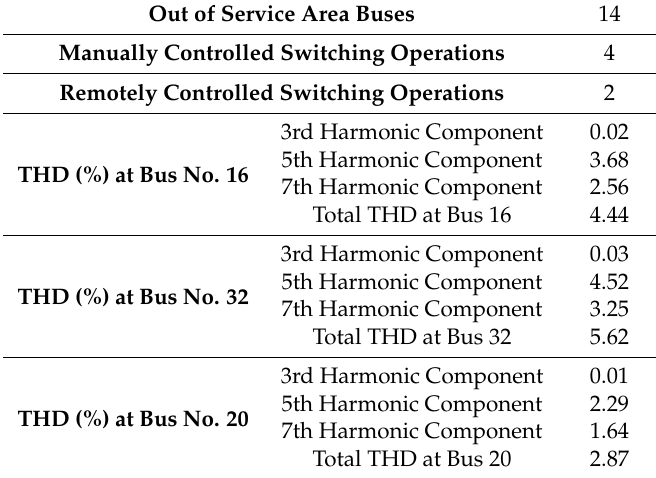
Table 10. Optimal values through Multi-Objective Particle Swarm Optimization (MOPSO) restoration plan when DC drive load is present.